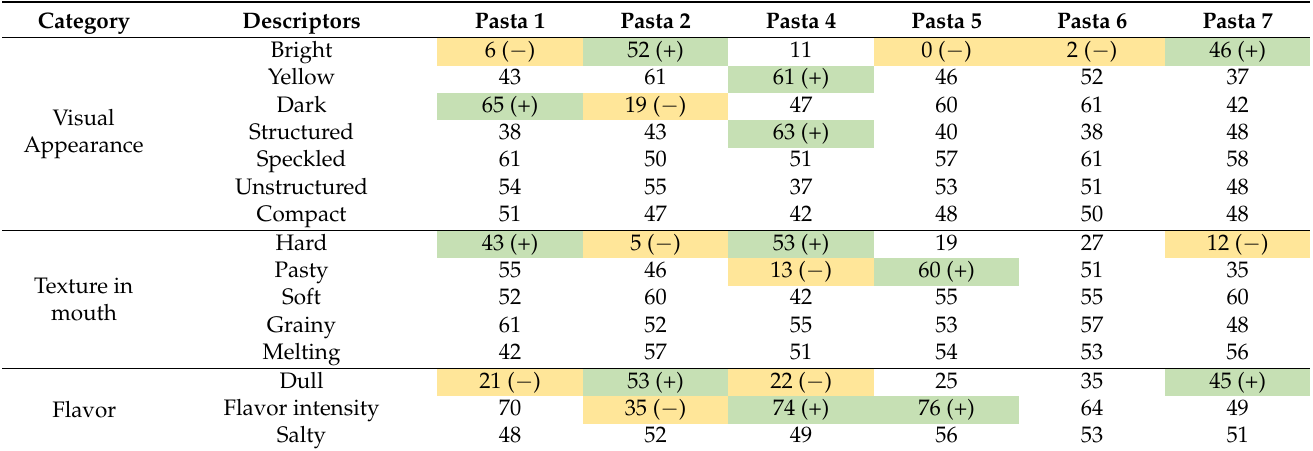
Figure 3. PCA plot of the pasta samples in terms of their physicochemical characteristics. Table 3. Contingency table obtained from the Pivot